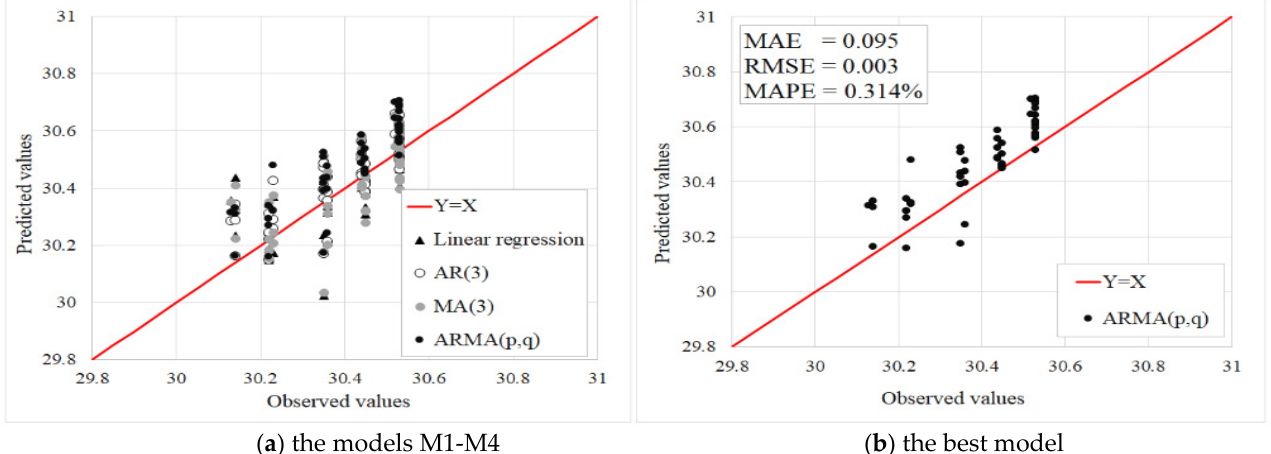
Figure 4. The case of missing value estimation in the time series of soil moisture (Vol. %), 48 h data gap length, 16–18 August 2016. Calculated by the authors based on the hourly time series, the data of monitoring network in Poluyamki, Altai Krai, Russia.